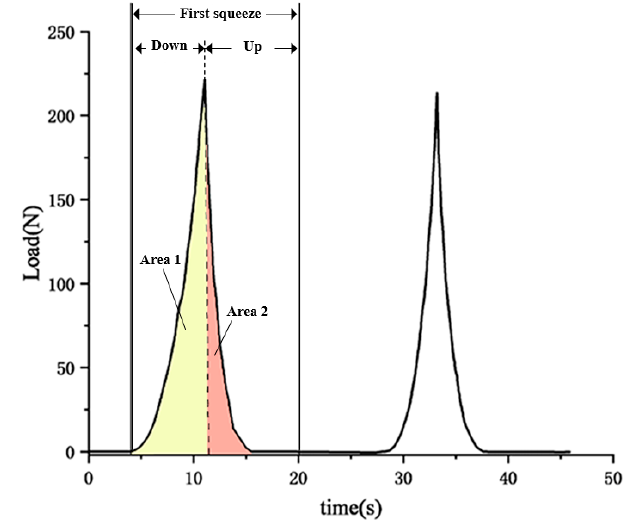
Figure 5. TPA test texture characteristic curve.